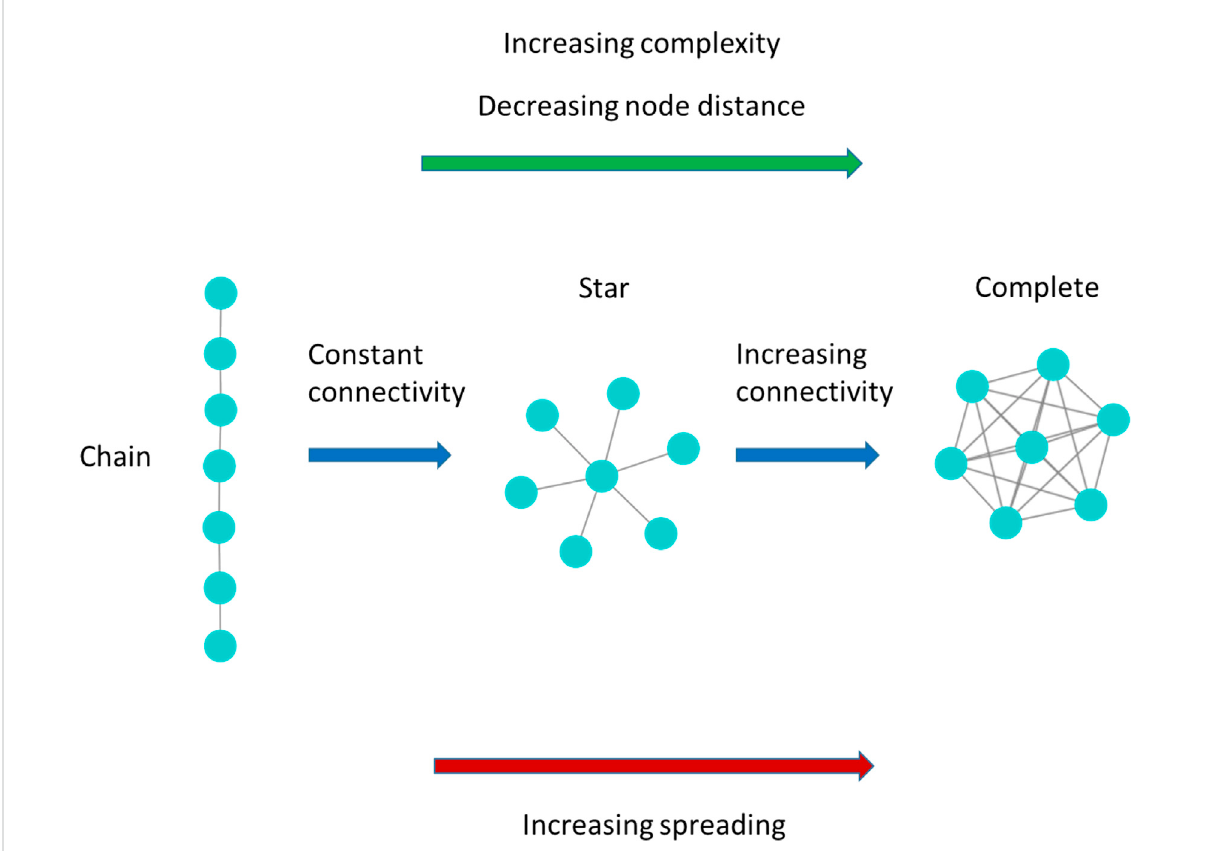
FIGURE 2 Model network examples of increasing complexity following Bonchev and Buck [16] theory of network complexity. When evaluating the complexity of the network with the rationale of the network structural indexes A / D and BB [16], the chain network is of lower complexity and low spreading pace, thestar network isof intermediate complexity and medium spreading pace, and thecompletenetwork isthestructure ofmaximum complexity, with the fastest spreading pace. The node distance always decreases with increasing complexity, i.e., passing from the chain to the star,andpassingfromthestartothecompletenetwork.Nonetheless,thenodeconnectivity(linkspernode)holdsconstantpassingfromthechainto the star network, whereas increasing from the star to the complete